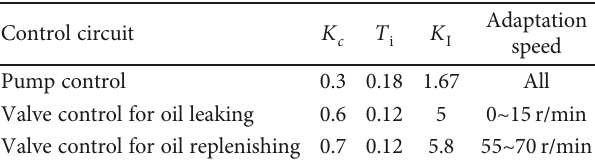
Table 2: PI parameter setting of each control circuit. Control circuit